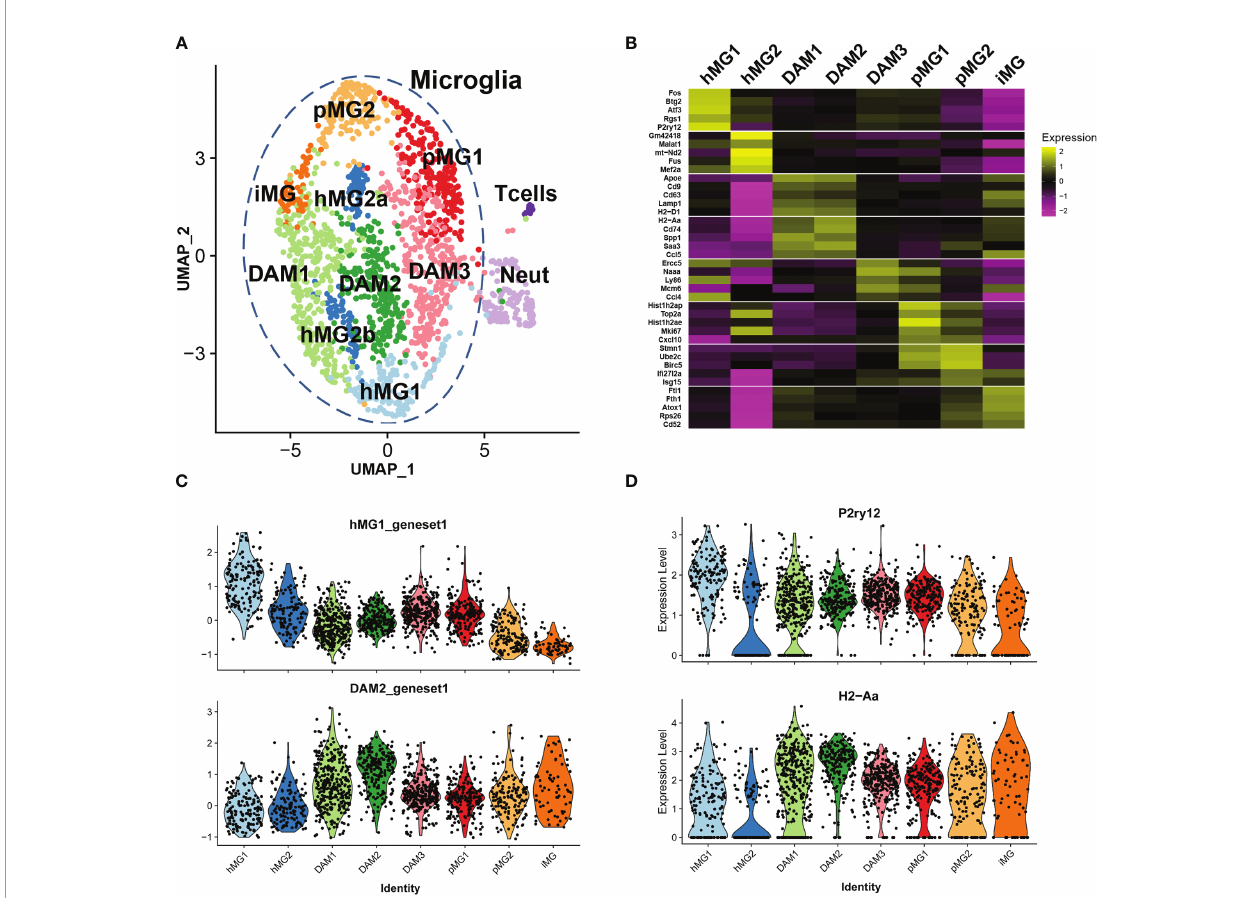
FIGURE 5 | Single cell transcriptional analysis reveals heterogeneous transcriptional states of microglia in EAE. Microglia were isolated by FACS from male p38 a CKO Cx3cr1-ER (CKO) and WT control mice (n=3 each) on day 21 post-EAE induction, as described in . ScRNAseq analysis was performed as described in Materials and Methods, using Seurat3 software. Combined analysis of WT and CKO cells is shown. (A) UMAP-based two-dimensional projection of cell clustering of major cell populations and transcriptional states. (B) Heatmap of signature gene markers for 8 microglial cell clusters. Row normalized gene expression is shown for 5 select signi fi cant cluster marker genes for each cell cluster. Average gene expression of all cells in each cluster is shown. (C) Violin plots demonstrating the expression of cluster module genes (as de fi ned in B ) for hMG1 (top) and DAM2 (bottom) modules, across 8 microglial clusters. (D) Violin plots demonstrating expression of select genes, P2ry12 (top) and H2-Aa (bottom), across 8 microglial